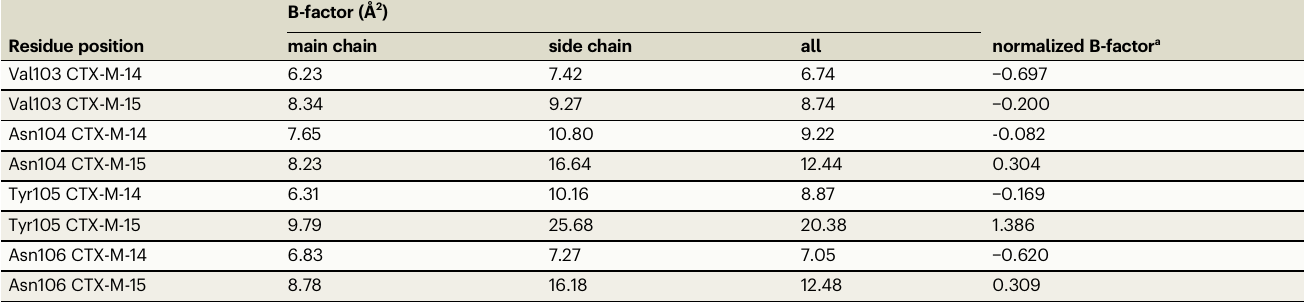
Table 3 | B-factors for residues in the CTX-M-14 and CTX-M-15 β -lactamase 103-106